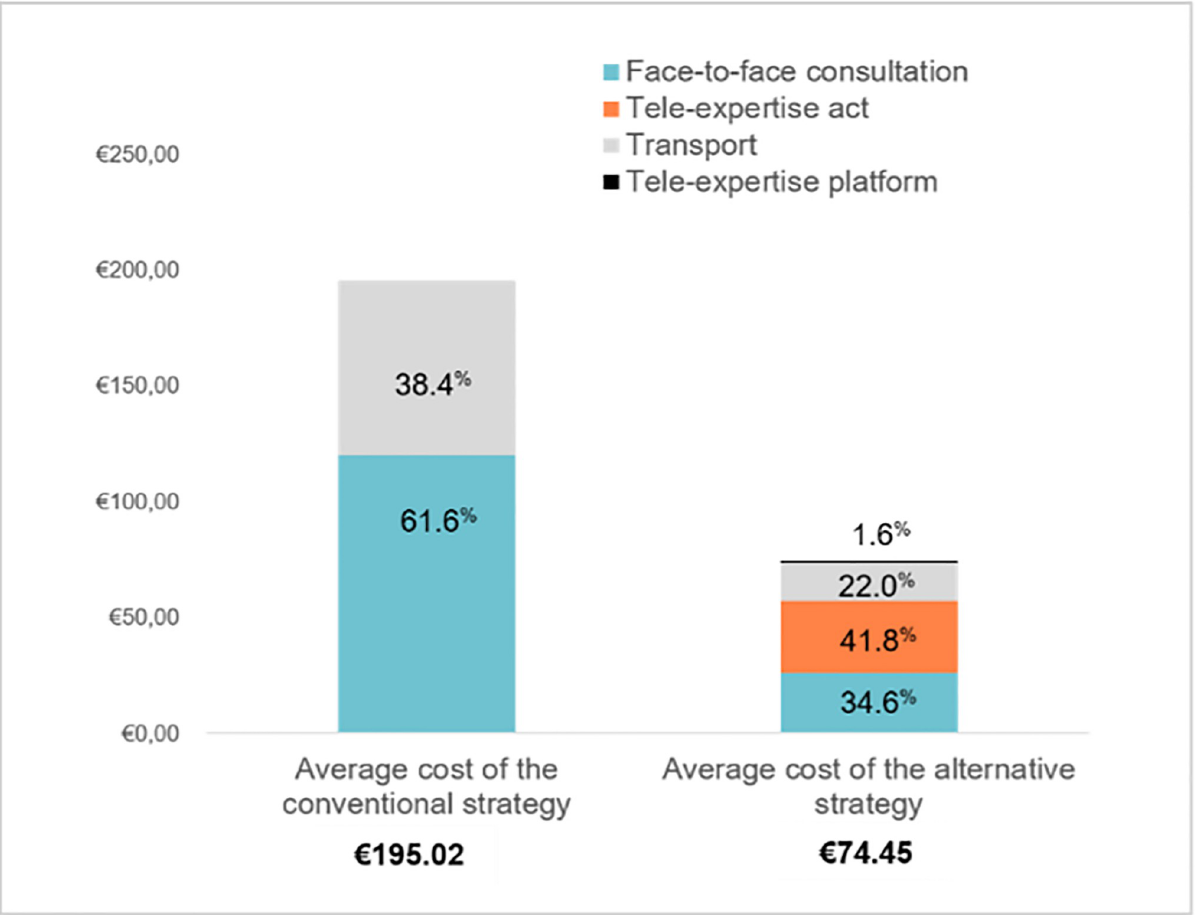
Fig 3. Distribution of average costs by